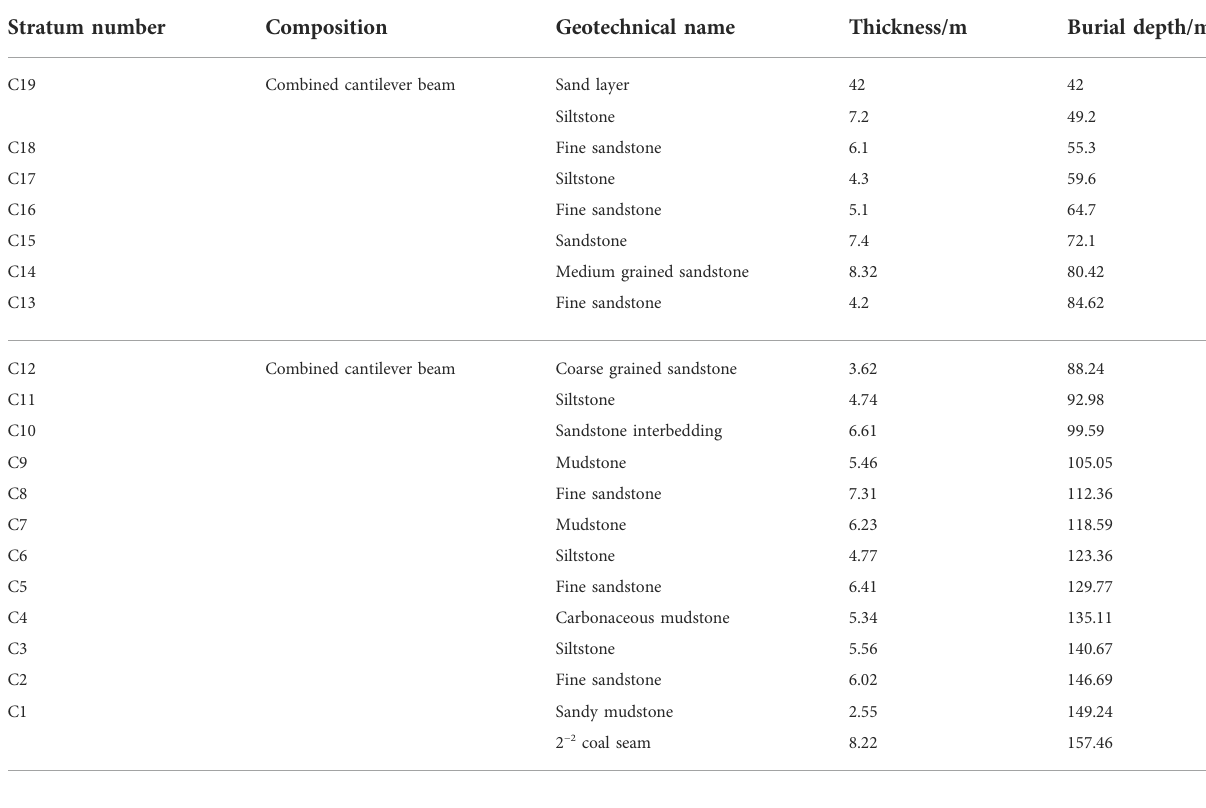
TABLE 4 Lithology of the no. 22,317 working face.